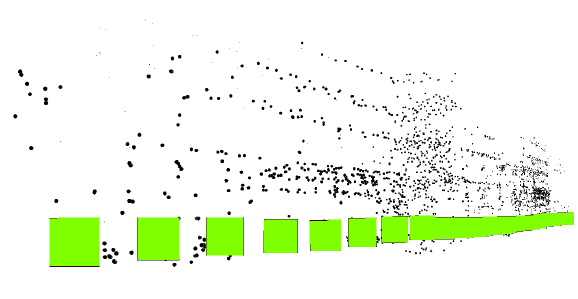
Figure 5. 3d point cloud and estimated camera path.